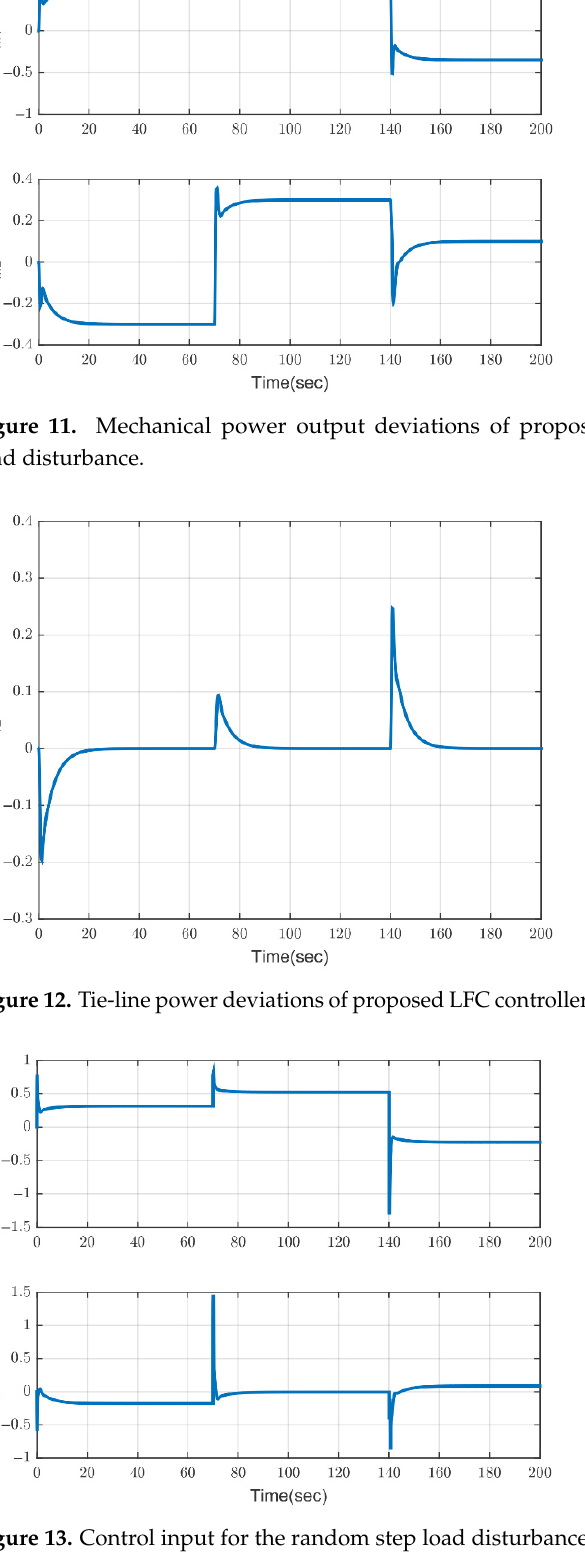
Table 2. Comparison of transient specifications of the proposed approach with other existed works for unit step load demand change. Parameter Peak Overshoot Peak Undershoot Settling Time Steady-State Error